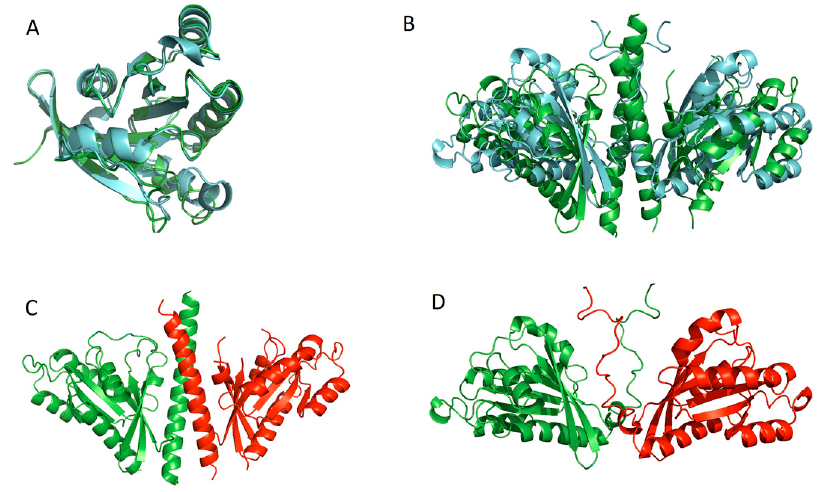
Figure 2. The challenge of making the transition from tertiary to quaternary structure prediction—a homodimer prediction. Even with a high quality starting tertiary structure other factors, such as disorder-order transitions, may come into play. ( A ) Superposition of Truncated Predicted and Truncated Observed Monomers of T0798 target Sequence with the observed monomer colored blue and the predicted monomer colored green; ( B ) Superposition of Predicted and Observed Dimer of T0798 target Sequence with the observed dimer coloured green and the predicted dimer colored blue, aligned with PyMOL; ( C ) Observed Dimer of T0798 Target Sequence with each of the two monomers coloured green and red respectively; ( D ) Predicted Dimer of T0798 Target Sequence with each of the two monomers coloured green and red respectively.